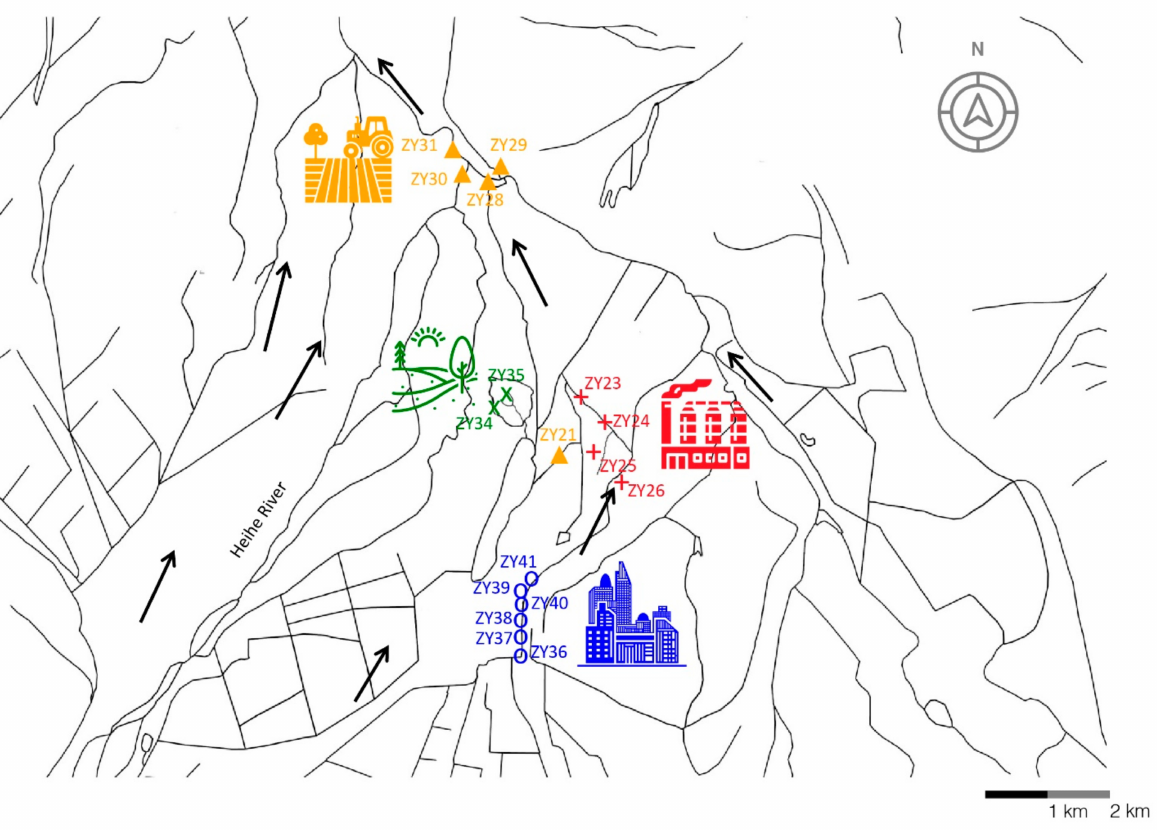
Figure 1. Map of the sampling sites (modified from Borruso et al. 2015). (cid:78) : Agricultural area sampling site; X: Natural park sampling site; +: Industrial area sampling site; o: Urban area sampling site; ↑ : Channel